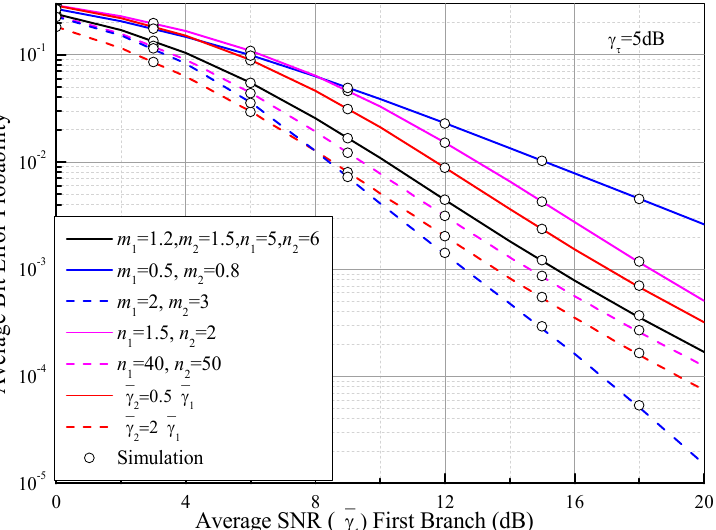
Figure 6. ABEP of DPSK for the dual-branch SSC as a function of the average SNR of the first branch ( 𝛾̅ (cid:2869) ) over i.n.i.d. Fisher–Snedecor ℱ fading channels with γ (cid:3099) = 5 dB.